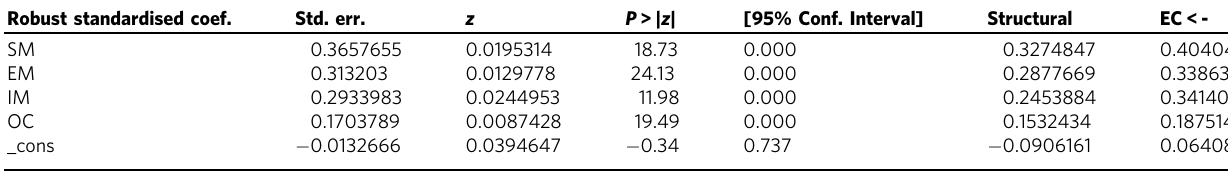
Table 3 Structural equations modell.